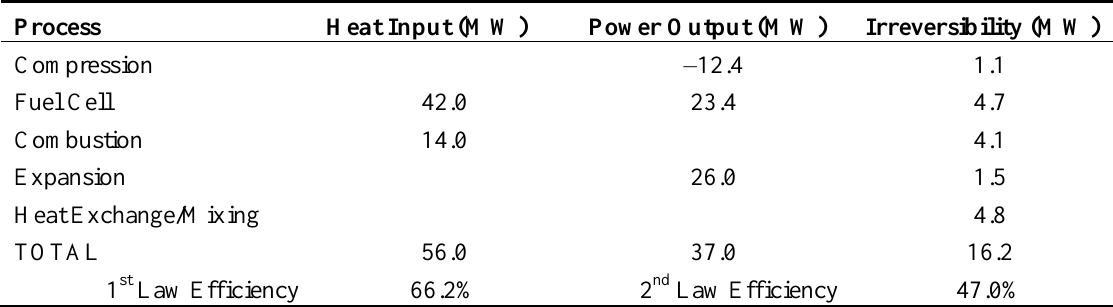
Table 2. Exergy breakdown of the hybrid